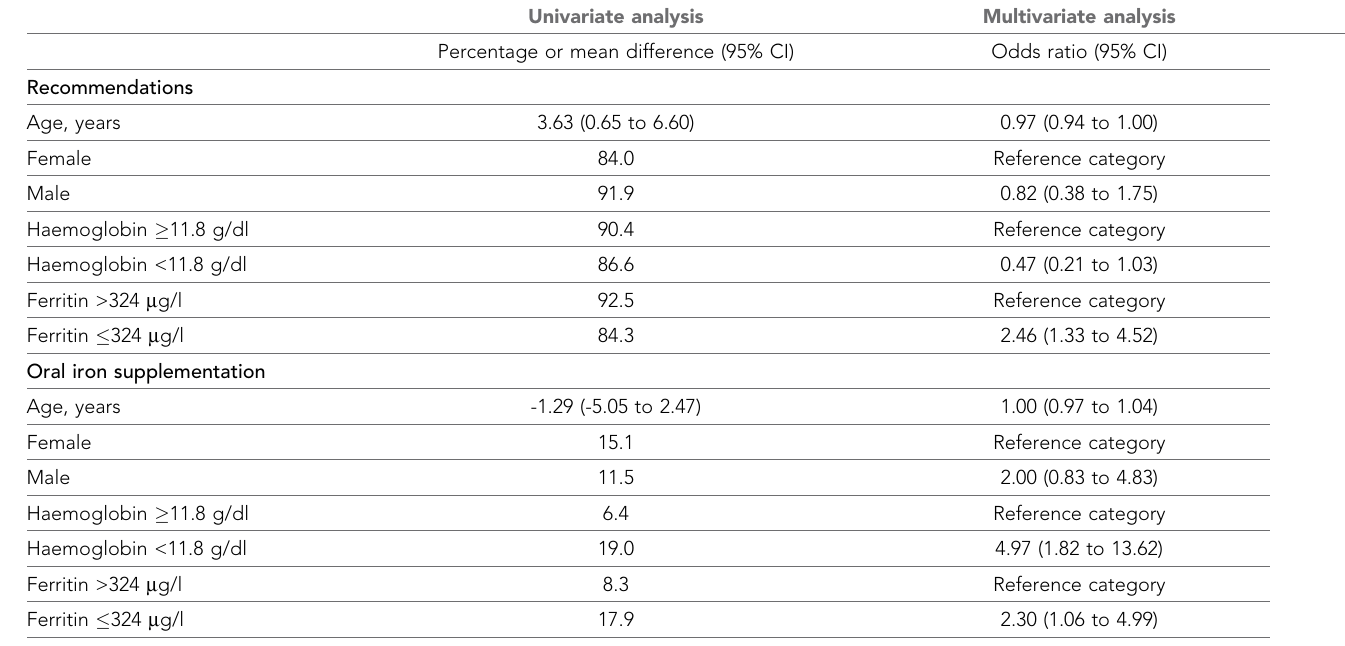
Table 4. Factors associated with implementation of the current recommendations and prescription of oral iron